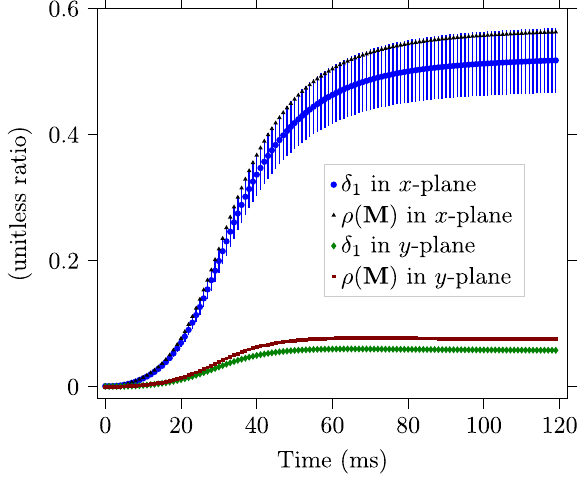
r 1 and ρ ð M ð t ÞÞ ; RMS w 0 ; RMS